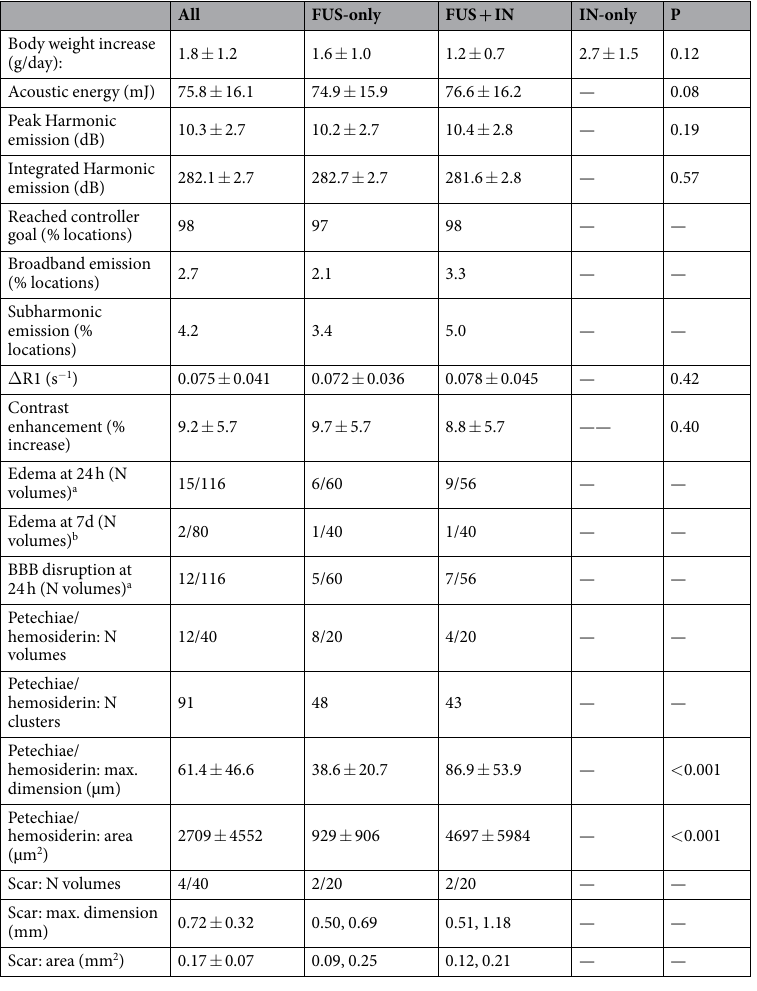
Table 2. Measurements and outcomes for FUS-only, FUS + IN, and IN-only groups. a No 24 h MRI in one animal. b No 7d MRI after session